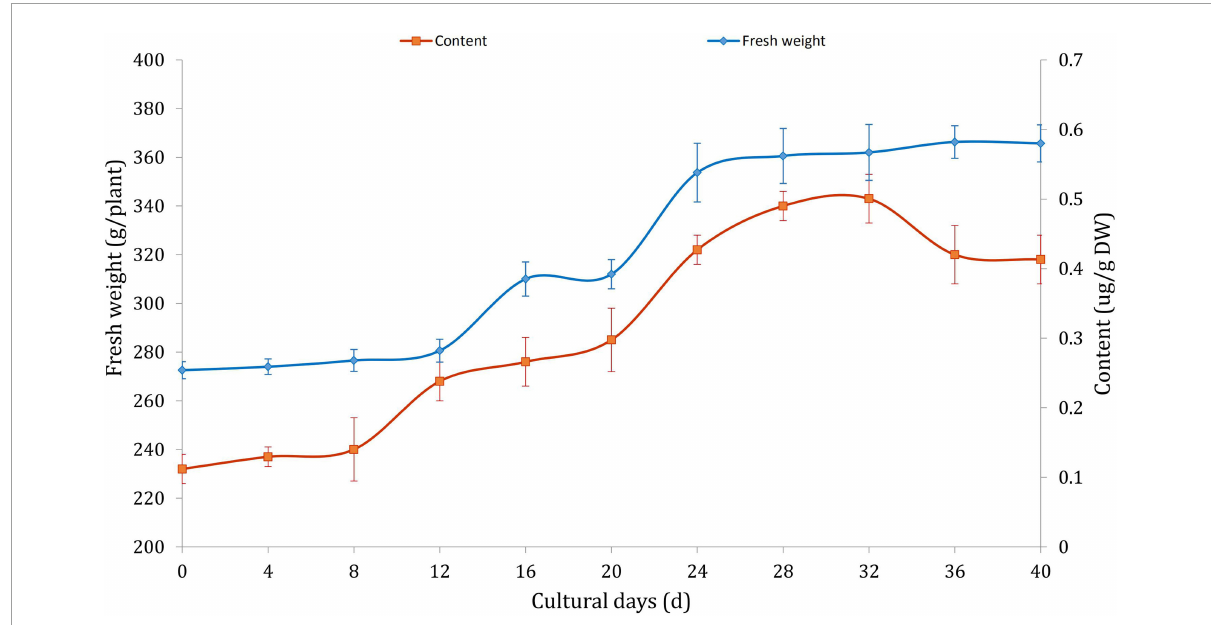
FIGURE1 The fresh weight and alkaloid contents of Dendrobium officinale treated with 100 µ M MeJA.